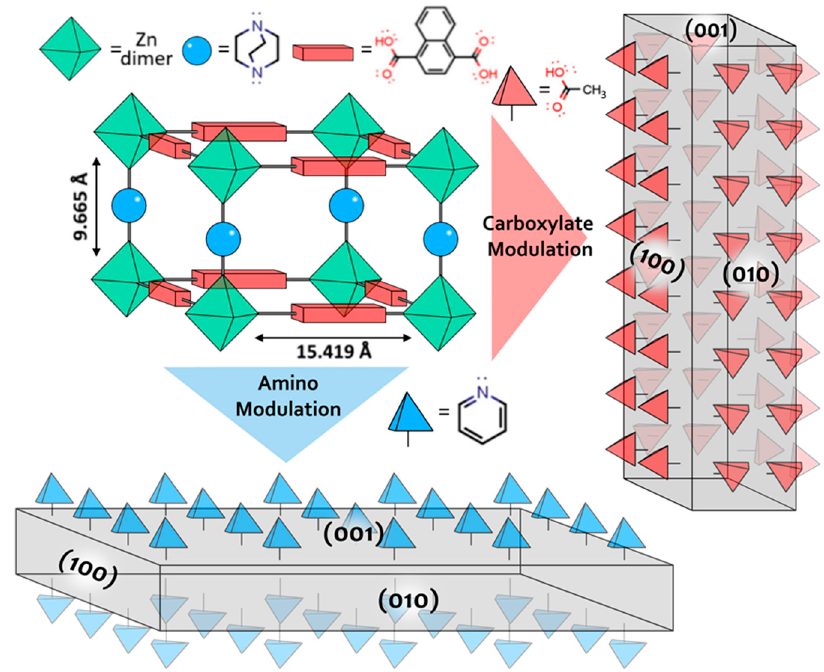
Figure 1. Schematic of the modulation process for the [Zn 2 (NDC) 2 (DABCO)] n MOF. Acetic acid (red pyramids) competitively coordinates with 1,4-naphthalene dicarboxylate (red rods) to direct growth in the [001] direction, while pyridine (blue pyramids) competitively coordinates with DABCO (blue spheres) to direct growth in the [100] and [010] direction.